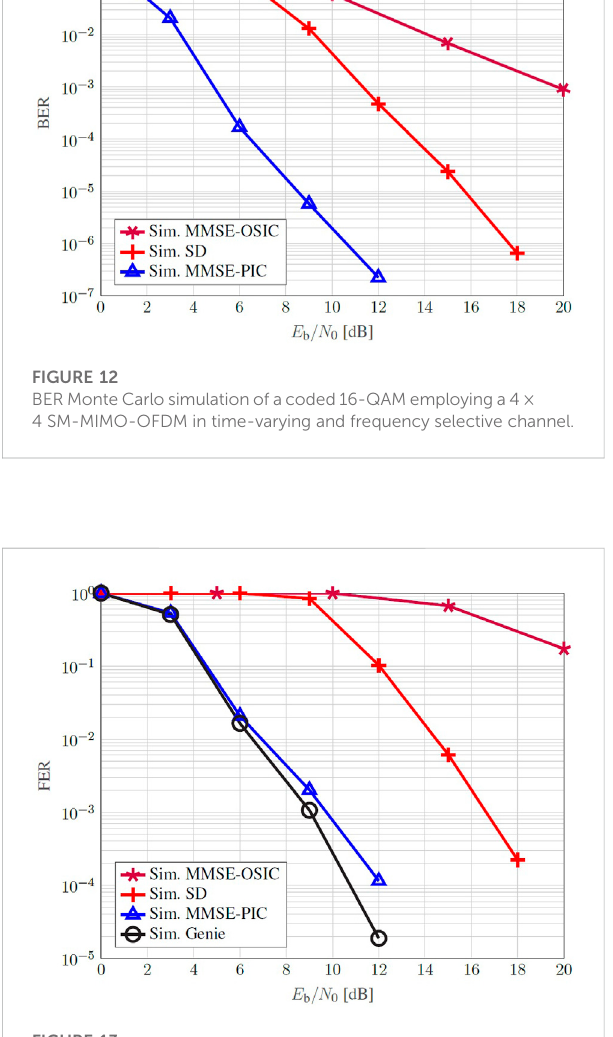
FIGURE 13 FER Monte Carlo simulation of a coded 16-QAM employing a4 × 4 SM-MIMO-OFDM in time-varying and frequency selective